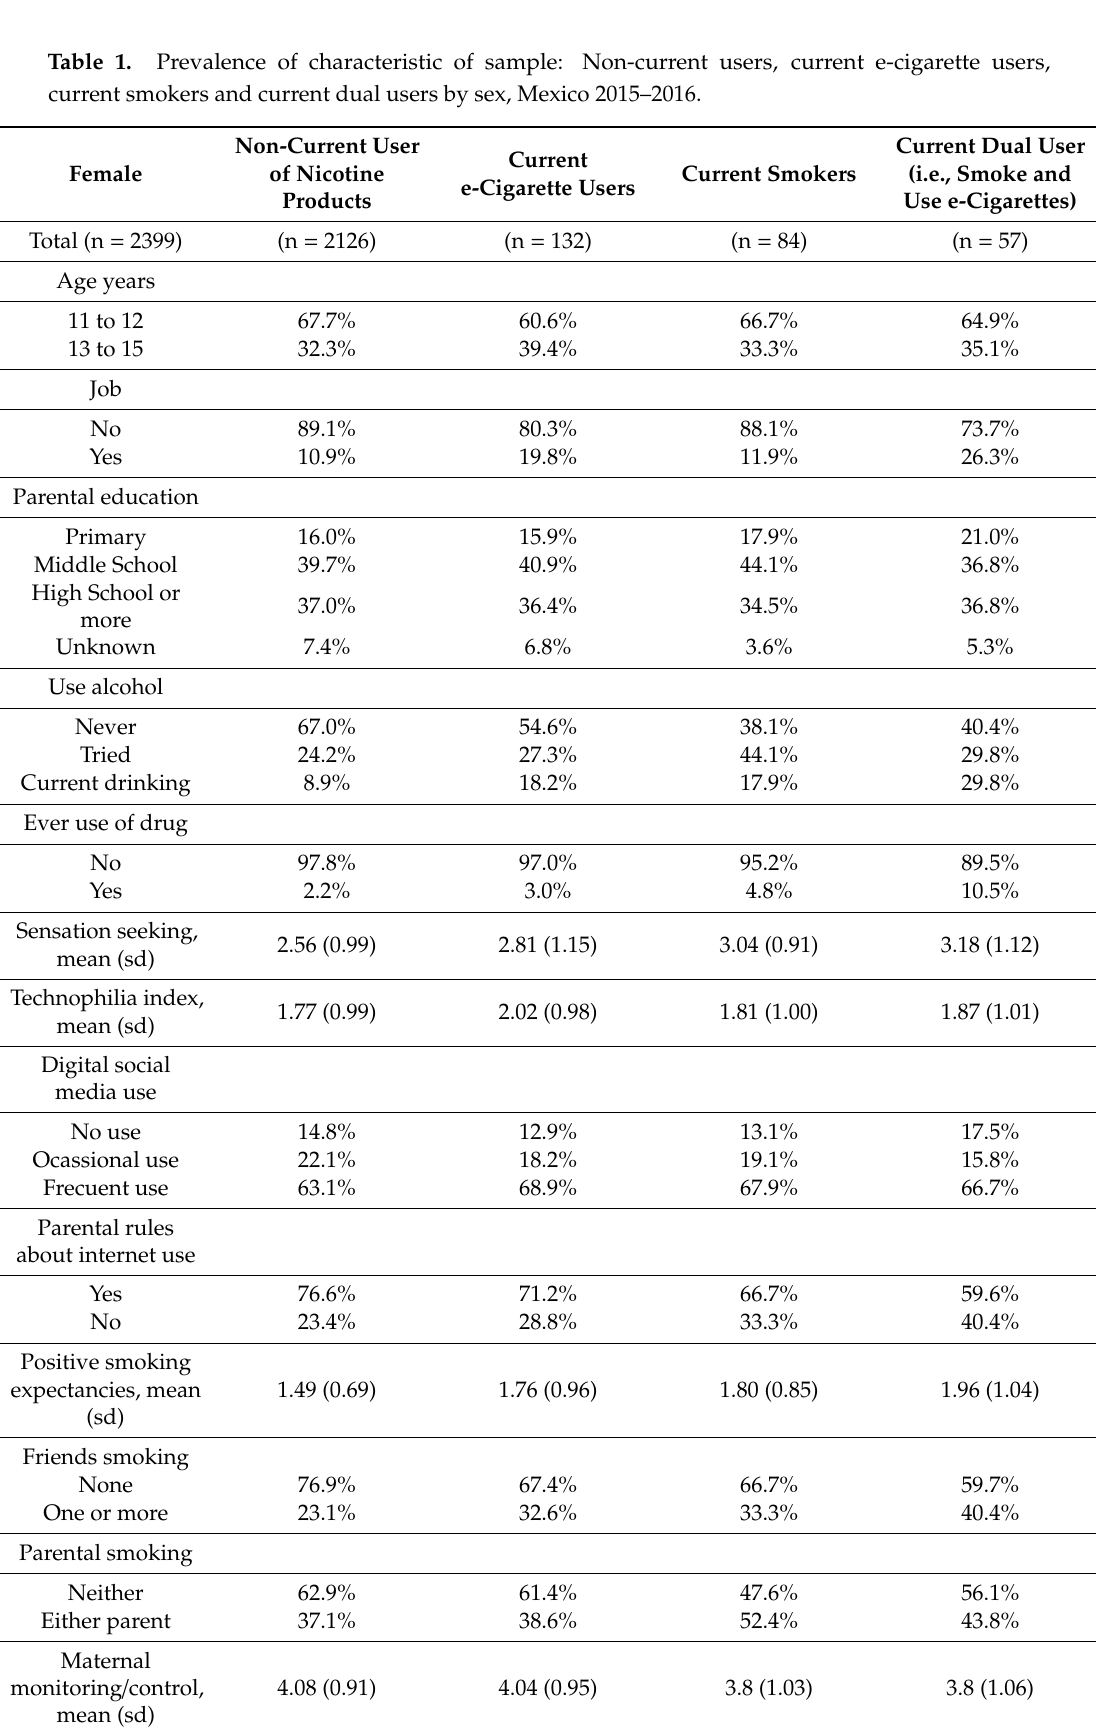
Table 1. Prevalence of characteristic of sample: Non-current users, current e-cigarette users, current smokers and current dual users by sex, Mexico